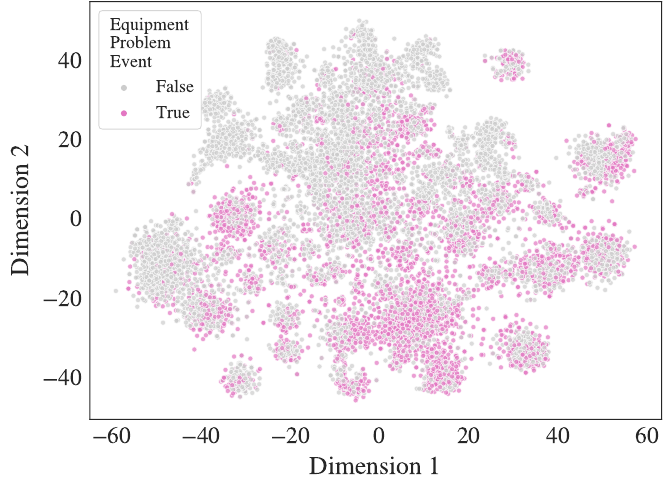
Figure 10. Presence of “Aircraft Equipment Problem Critical” Event. Table 4. Correlation Coefficient between “Aircraft Equipment Problem Critical” event and cluster